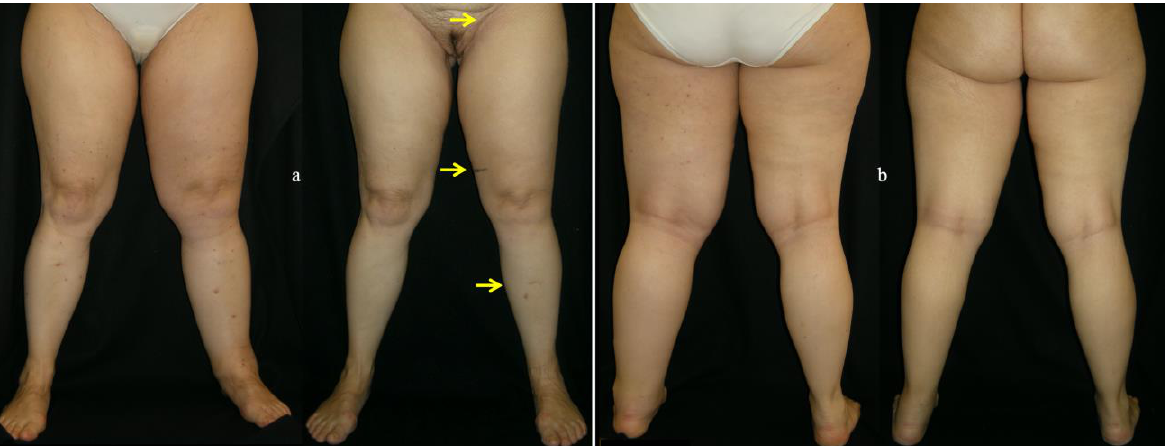
Figure 2. This pie graph shows the patients’ outcomes after surgery in terms of reduction in the mean circumference of the limb.